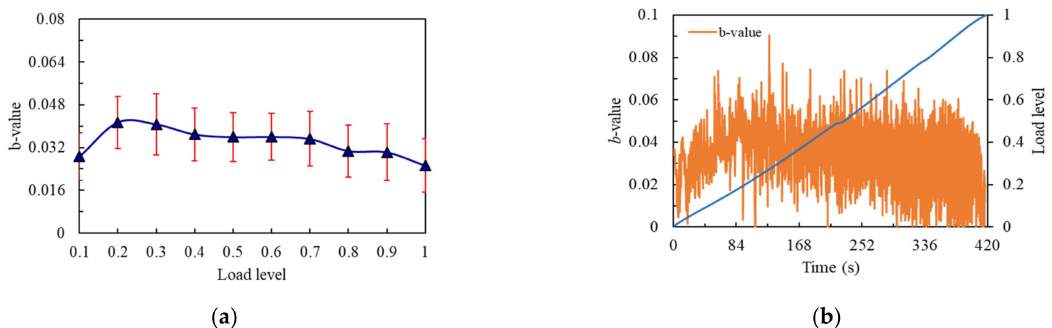
Figure 11. b -value curves of the No.11 notched beam: ( a ) b -value changes curve with load level; ( b ) b -value changes curve with time.